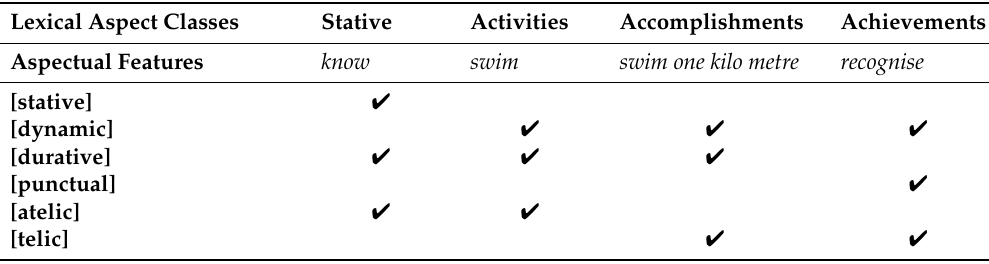
Table 1. Four lexical aspect classes of verbs.